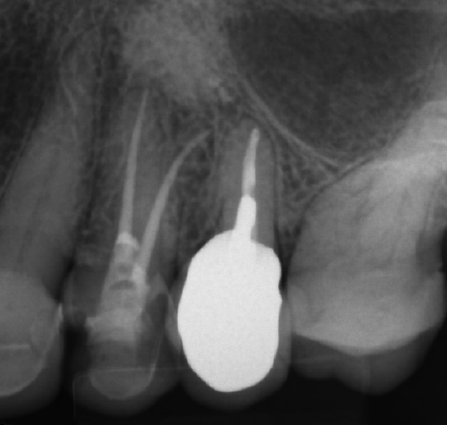
Figure 23. X-ray image showing the correctness of the performed root canal treatment.